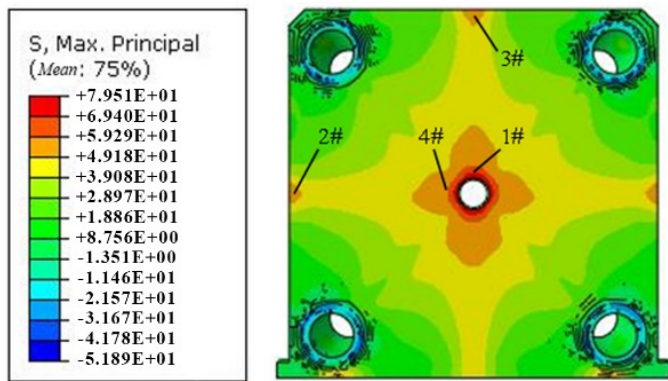
Figure 5. Distribution of measuring points.